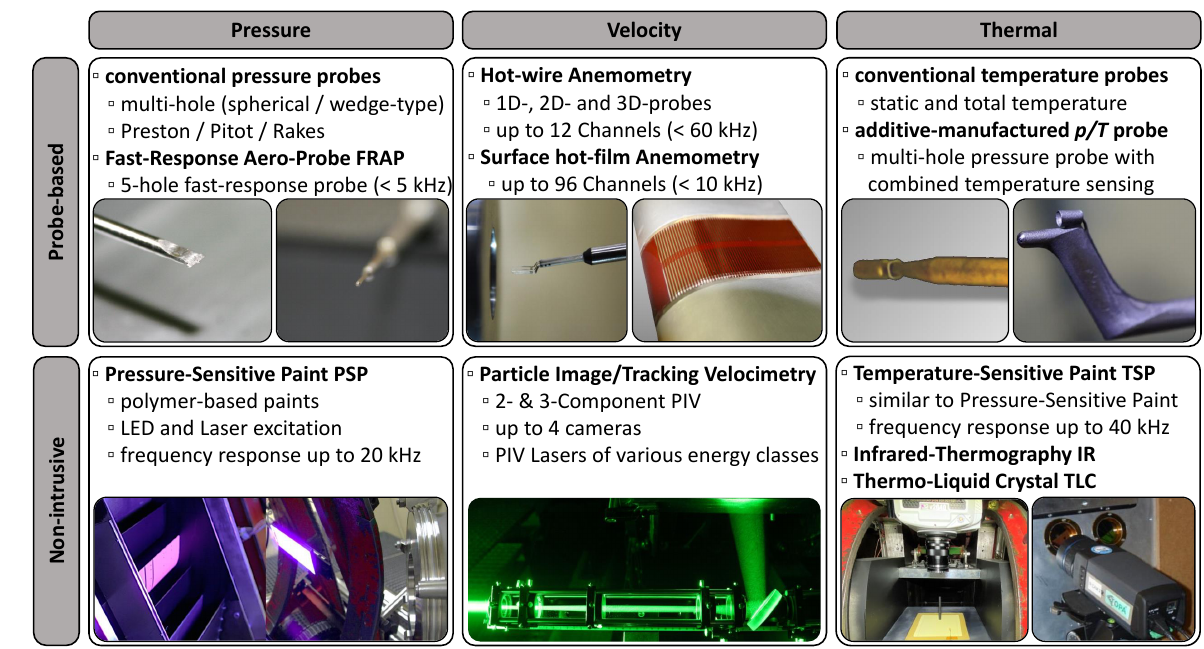
Figure 12. Portfolio of measurement techniques commonly applied in the HGK. Apart from the newest probe-based pressure measurements, the application of non- intrusive optical flow sensing techniques, i.e., Particle Image Velocimetry (PIV), Pressure- and Temperature-Sensitive Paints (P-/TSP) or Infrared Thermography (IR-T), was heavily raised within the last years. As all these diagnostic methods have in common the need of at least one camera, the optical access to the test specimen is inevitably required. In case, the test design requests the application of one of these techniques, the test specimen must be designed in an appropriate manner. Actively cooled LED light sources as well low-pressure environment. In order to prevent calibrated cameras (e.g., IR cameras)